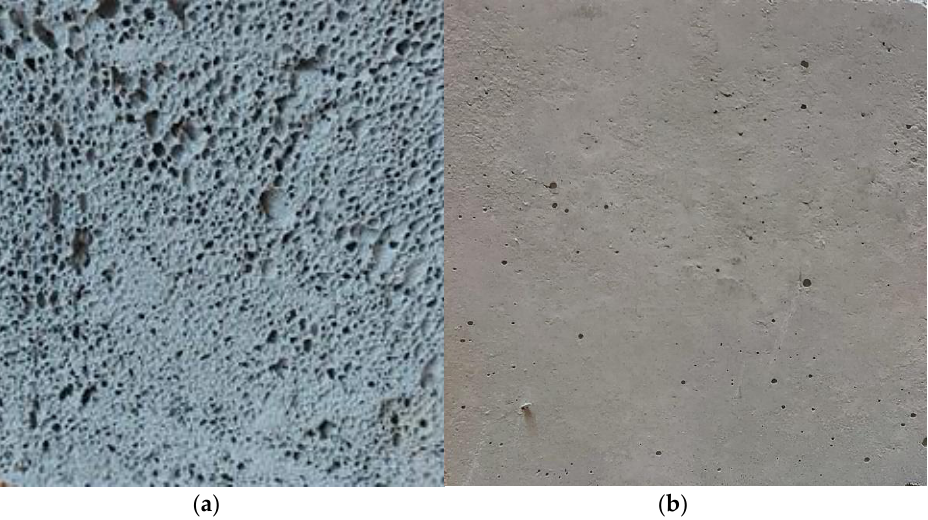
Figure 1. Samples used in thermal tests after 28 days of conditioning in heat/humid conditions: ( a ) geopolymer, ( b ) gypsum. Table 1. Composition of the geopolymer pastes and modified gypsums used in the research.